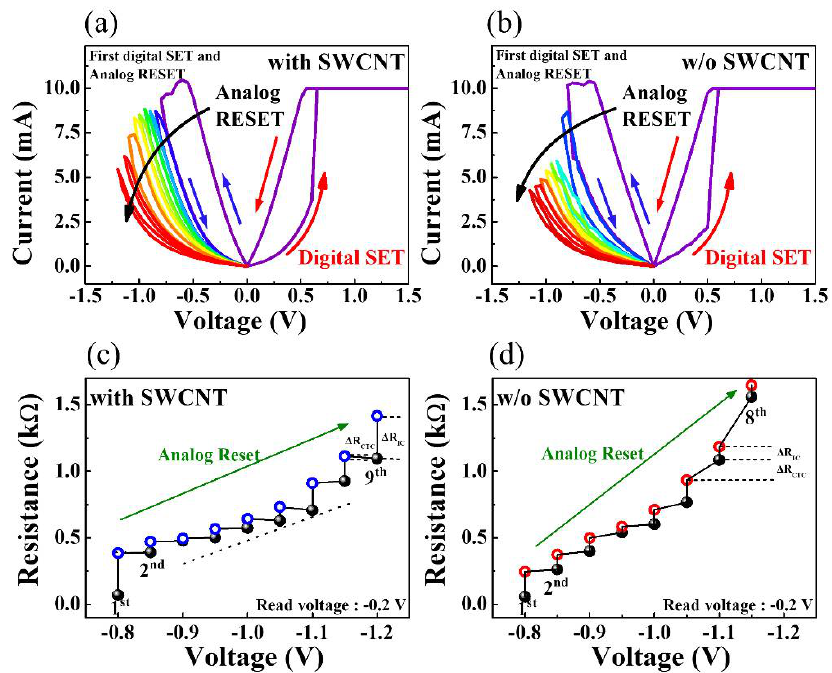
Figure 6. Analog RESET process of chitosan memristors ( a ) with and ( b ) without SWCNT random networks. Changes in resistance extracted at a read voltage of −0.2 V for chitosan memristors ( c ) with and ( d ) without SWCNT random networks.